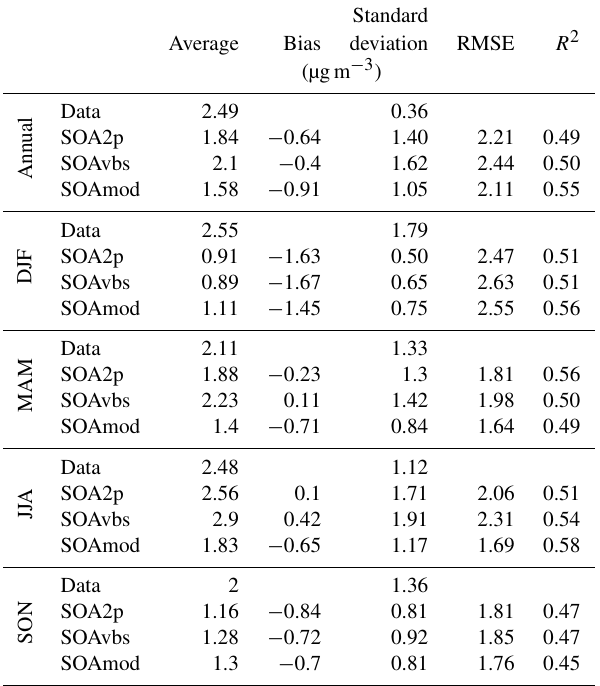
Table 1. Statistical information for different schemes in regard to measurements. In this table are the average for the data and each scheme, the bias, standard deviation and root-mean-square error (RMSE; all in µgm − 3 ). R 2 shows the correlation of determination for each scheme. Figure 3 shows the Taylor diagram and the box- plots for these